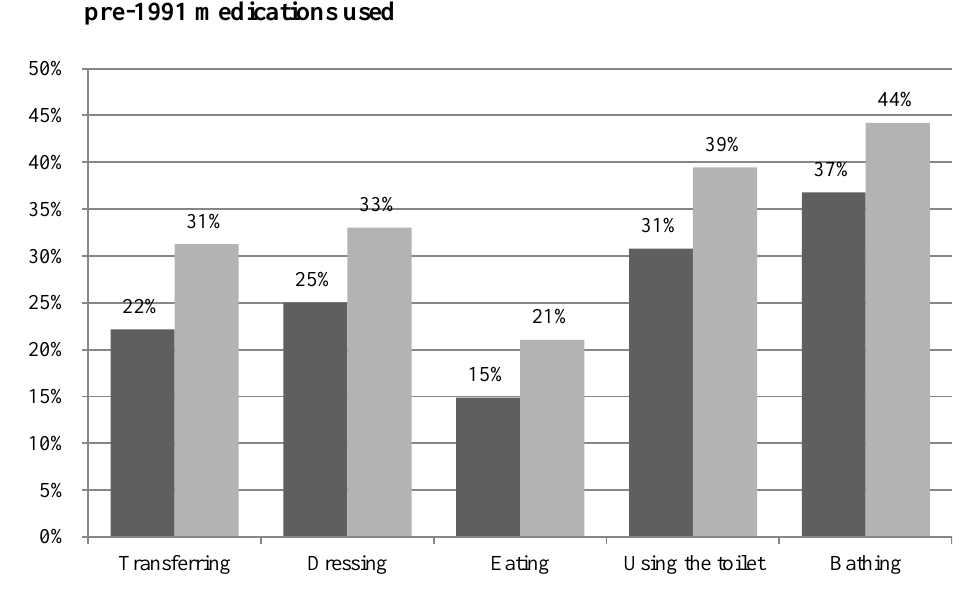
Figure 2: Probability of being totally dependent in 2004: actual vs. predicted if only pre-1991 medications